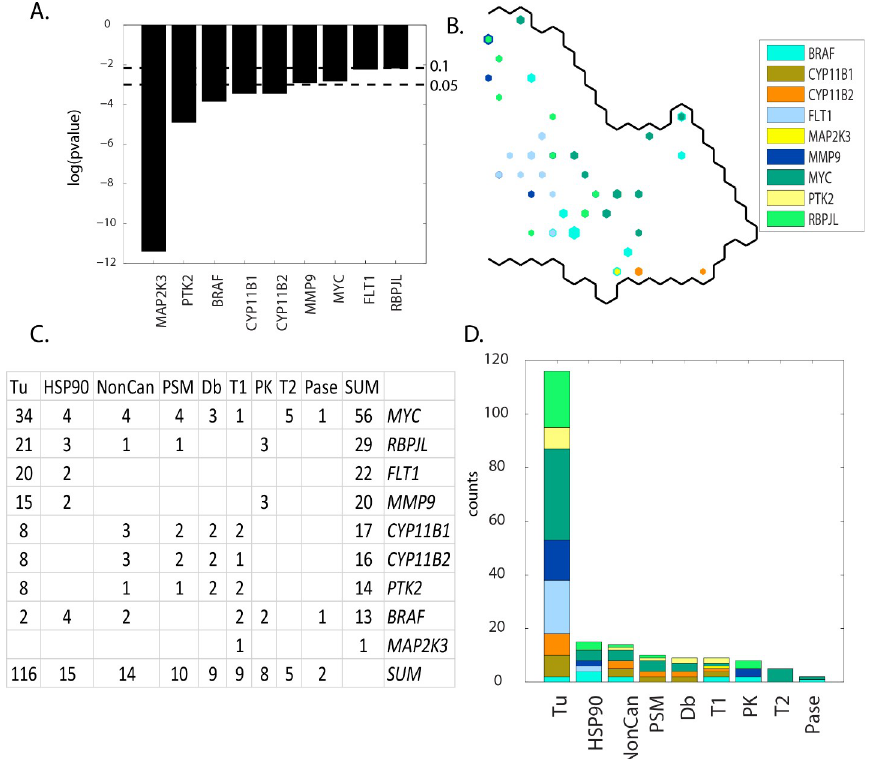
Fig 12. Results for group D(meta-clades 16 through 18). The SOM DTP region displayed in Panel B represents the boundary for meta-clades 16 through 18 (see the white border in Fig 8 Panel A ). S9 master_appendix sheet gp_D lists the table in Panel C. See legend of Fig 9 for additional details. S16 master_appendix sheet gp_D_FDA lists the FDA compounds associated with these defective